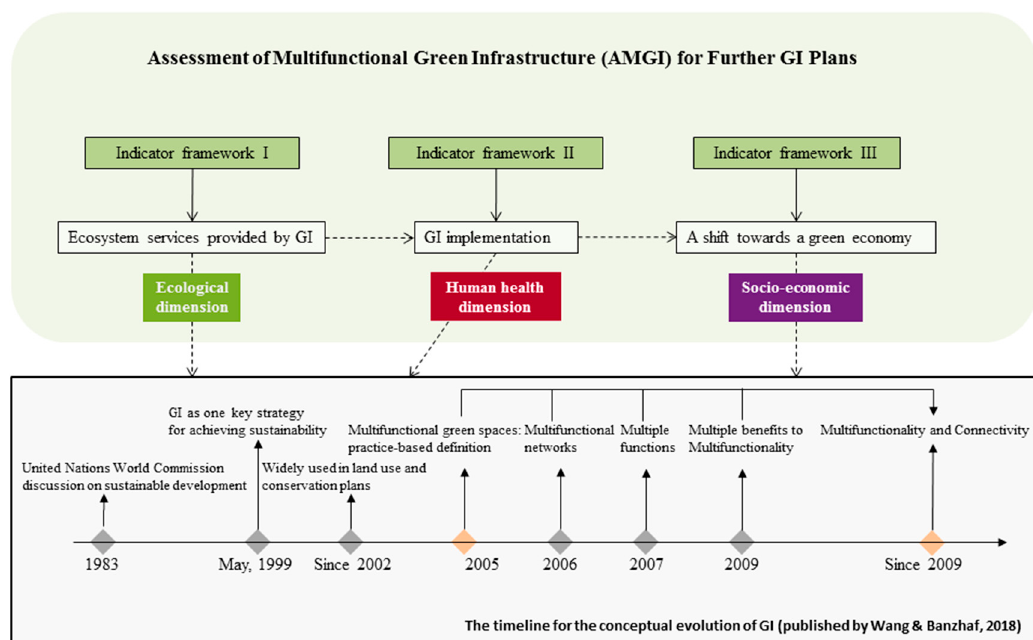
Figure 1. Potential contributions of selected indicator frameworks I to III for Assessment of Multifunctional Green Infrastructure (AMGI) (dashed arrows indicate the potential contributions; arrows show proven developments).